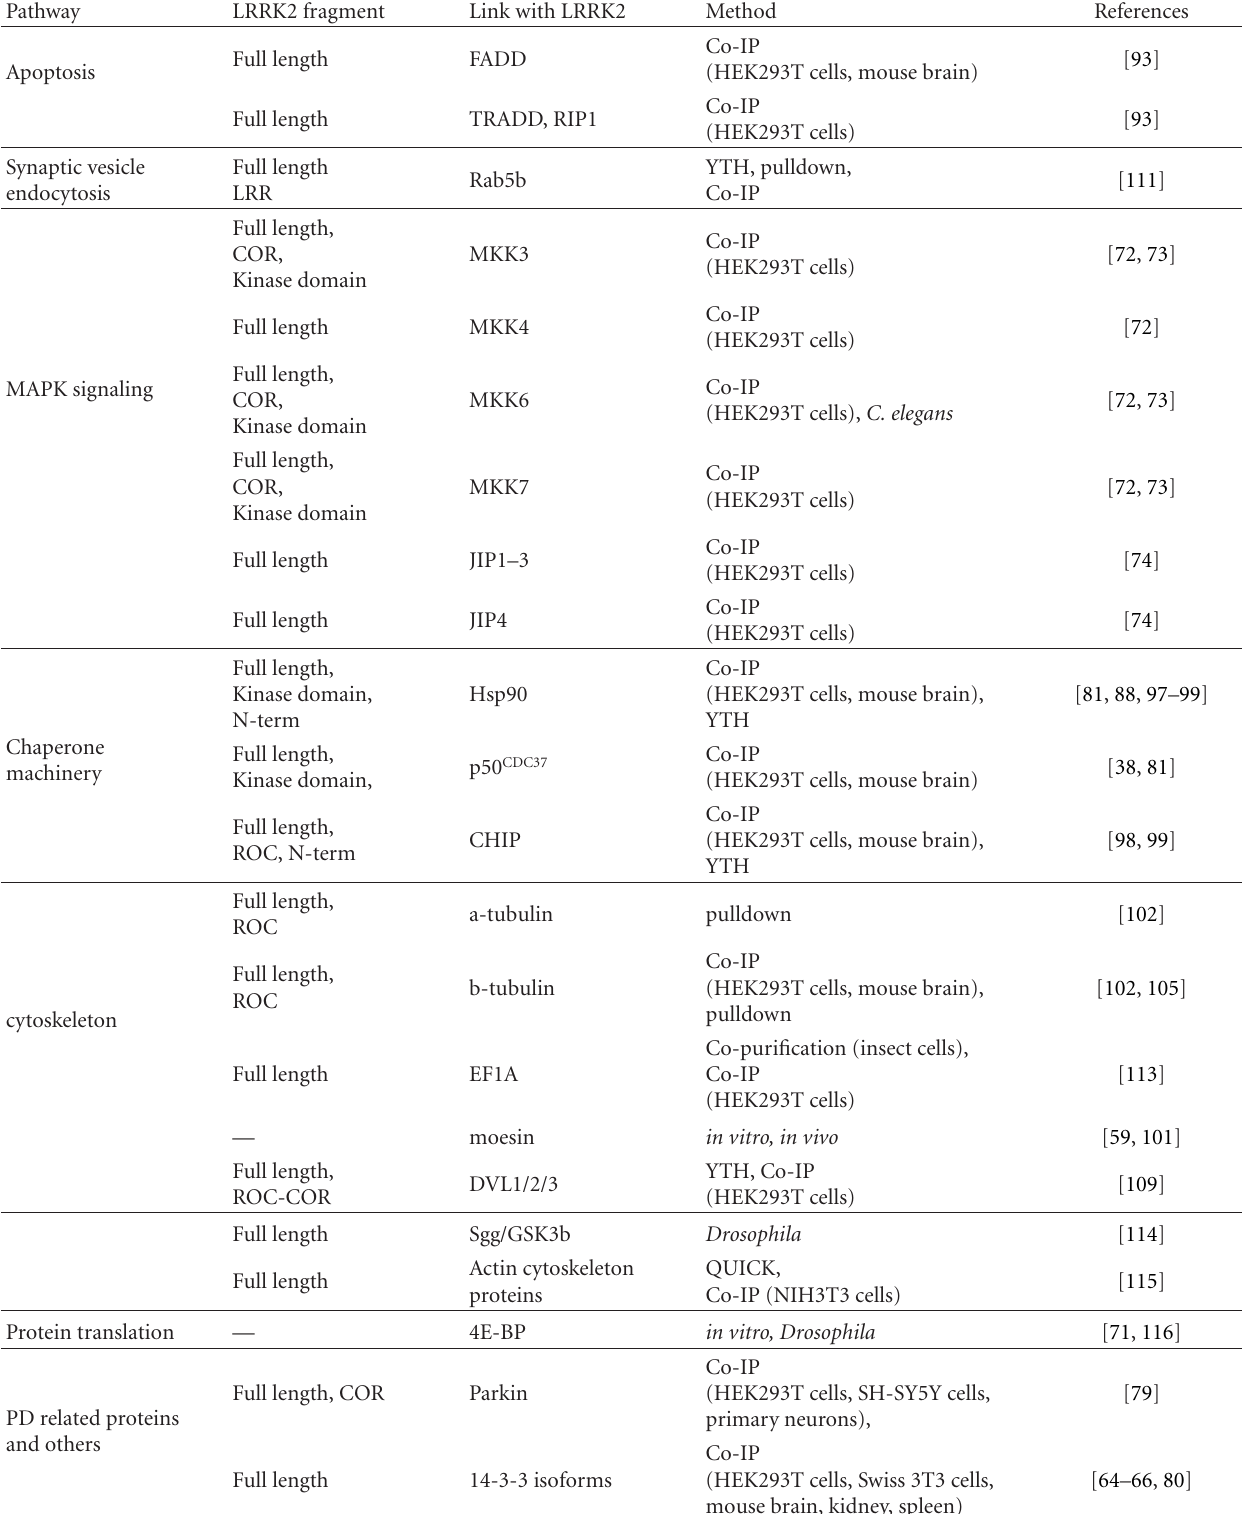
Table 2: LRRK2 potential interaction